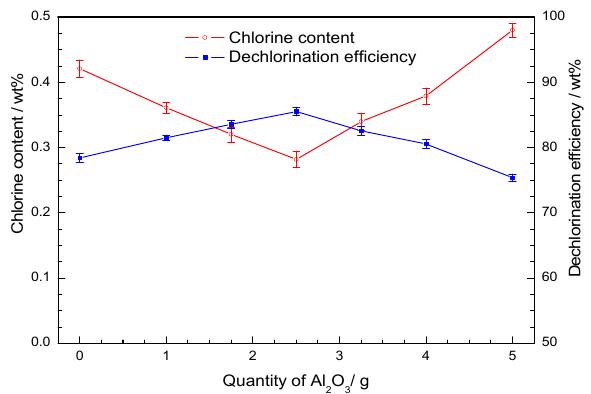
Figure 2. Influence of the carrier mass ratio on the catalytic DC property.